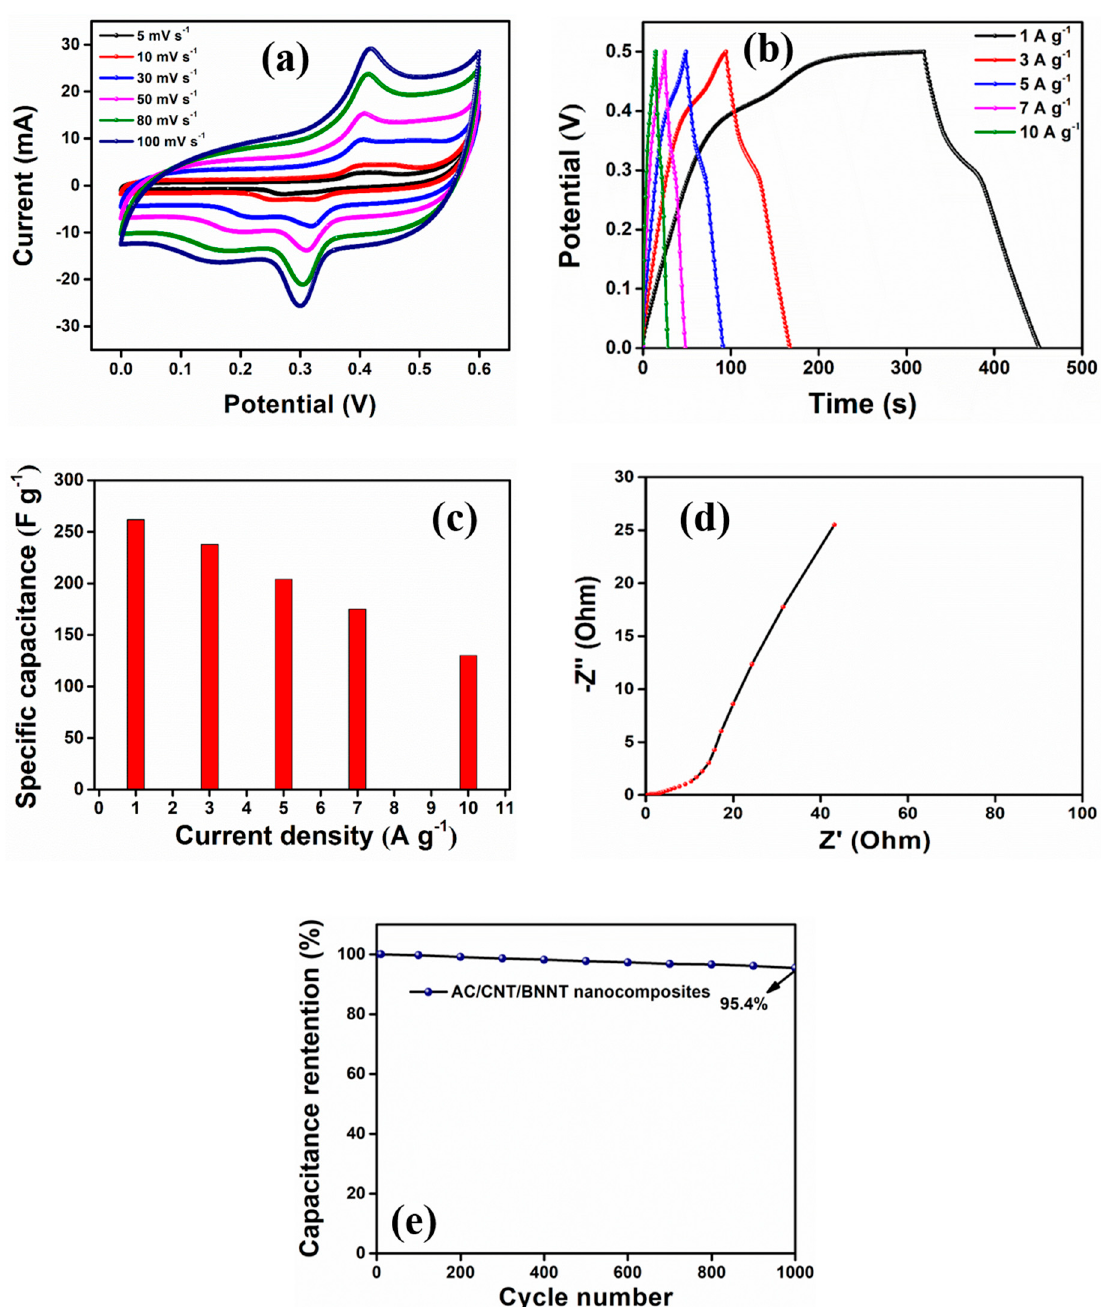
Figure 6. Electrochemical characterizations of the printed MWCNTs/AC/BNNTs ternary composite material with an optimized BNNT content: ( a ) cyclic-voltammetry (CV) response measured at various scan rates; ( b ) galvanostatic charging-discharging (GCD) curves measured at various current densities; ( c ) measured specific capacitance at various current densities; ( d ) electrochemical impedance spectroscopy (EIS) measurements; and ( e ) cycling stability performance of the MWCNTs/AC/BNNTs ternary composite material.